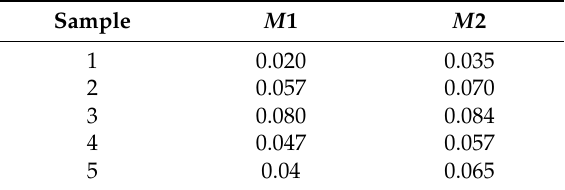
Table 7. Refined iron content of octahedral M 1 and M 2 sites for 1 – 5 samples ( apfu ).